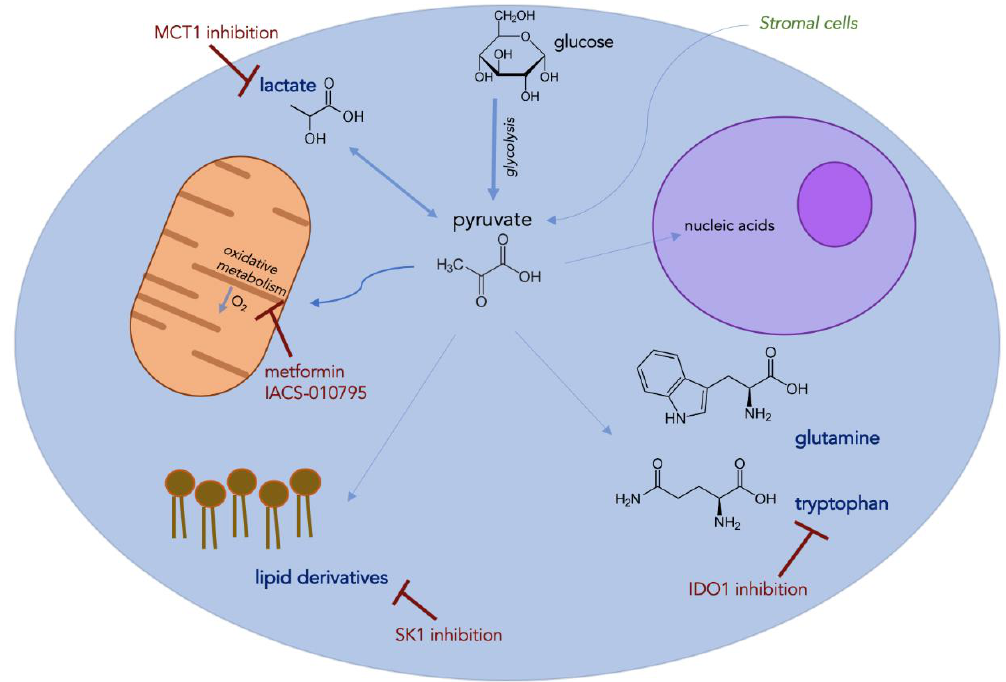
Figure 1. Tumor cell schematic highlighting known immunosuppressive metabolic factors with examples of proposed therapeutic interventions to be used alongside current immune-based therapies.